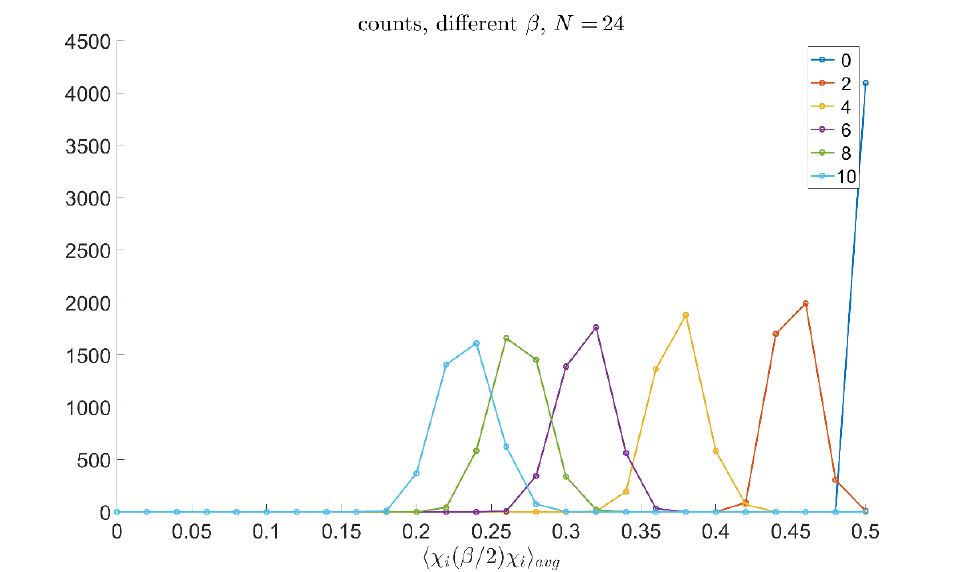
JHEP07(2019)065